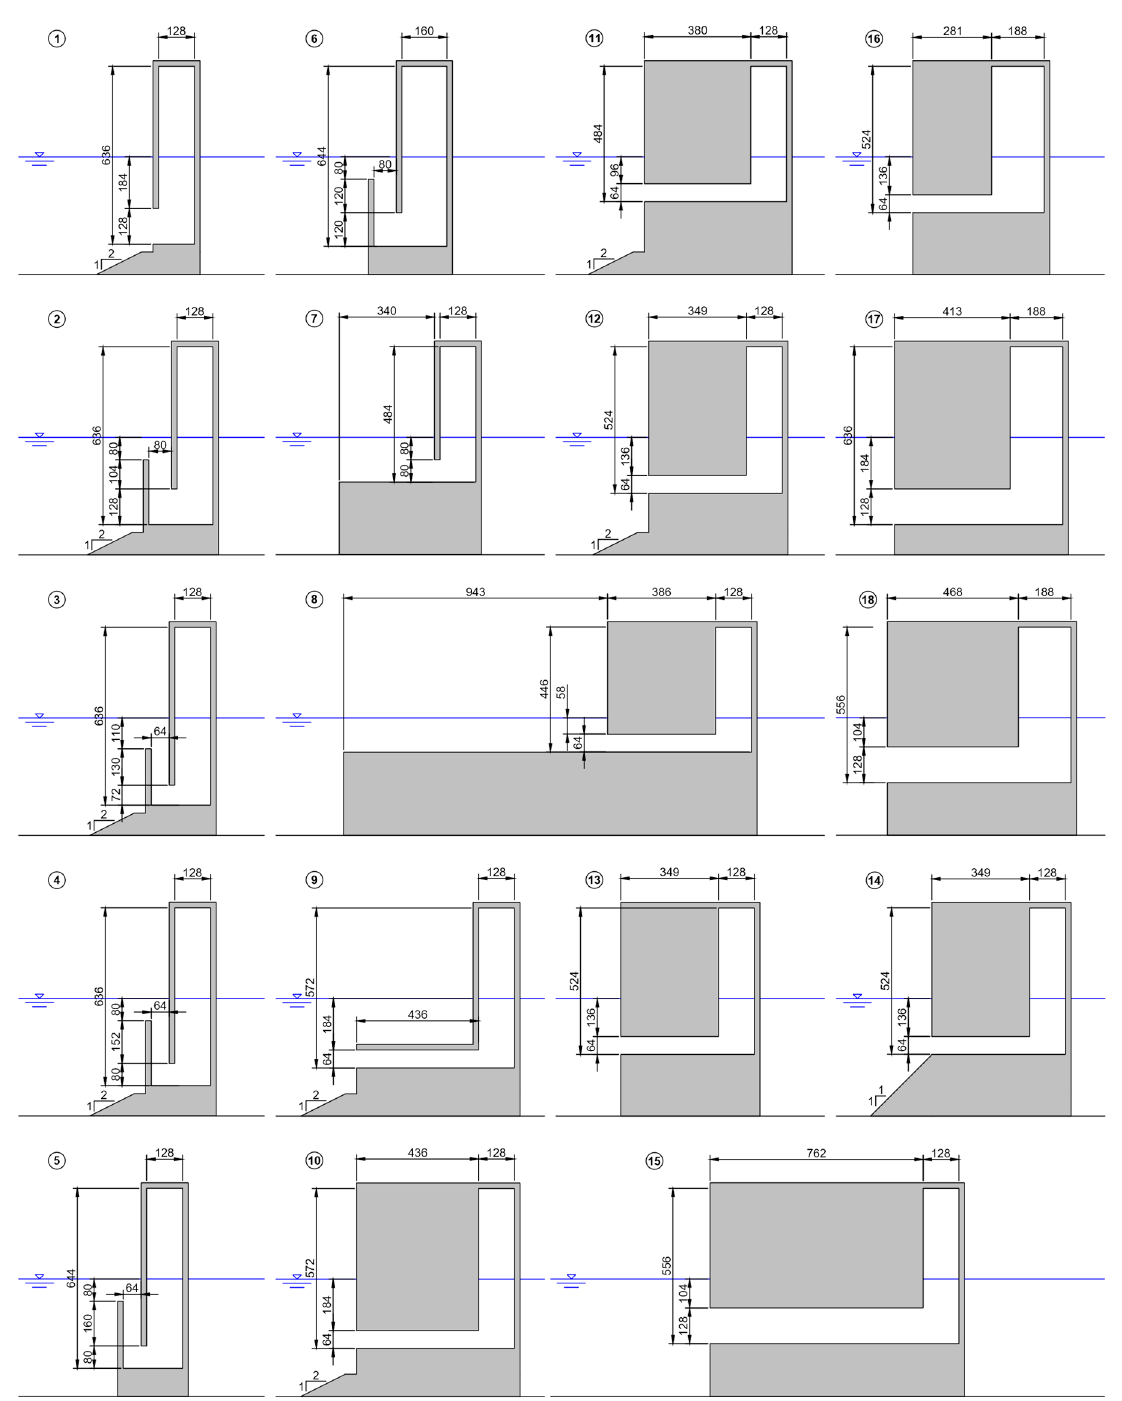
Figure 5. Geometries of the OWC designs studied in the numerical model (dimensions in model scale in [mm]). The eighteen models were tested under six different regular wave conditions resulting from the combination of four wave periods T = 1.2, 1.6, 2.0 and 2.4 s ( T = 6, 8, 10 and 12 s, in prototype dimensions) with a wave height of H = 0.04 m ( H = 1 m, in